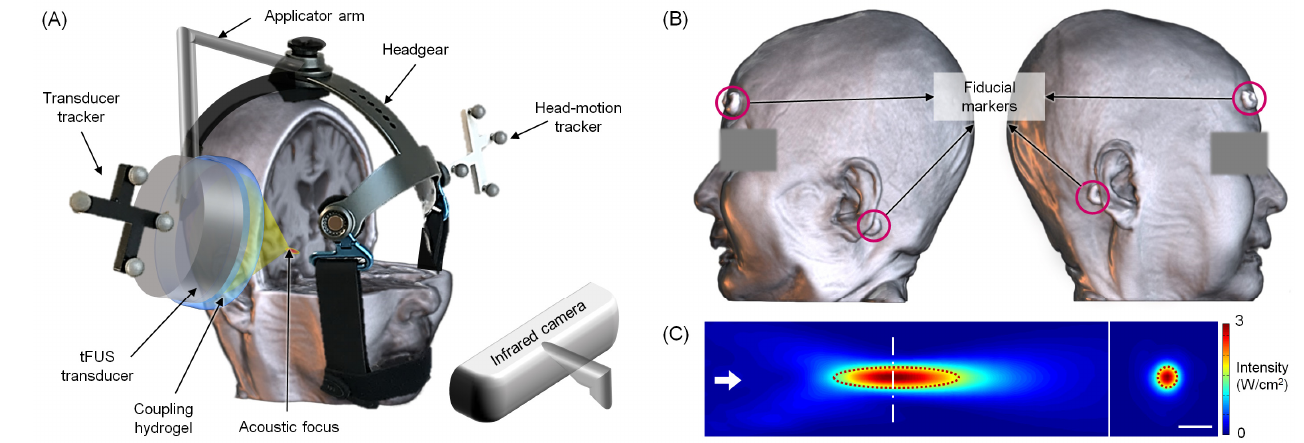
Figure 2. ( A ) Illustration of the experimental setup for transcranial focused ultrasound (tFUS) sonication to the right hippocampus of patients with Alzheimer’s disease. Image-guided real-time navigation was performed using the motion-tracking infrared camera which monitors the location and orientation of the headgear and the FUS transducer through optical trackers. The transducer is placed over the entry point on the scalp, and the coupling hydrogel is positioned between the transducer and the scalp. The sonication path is overlaid on the T1-weighted magnetic resonance imaging (MRI) of a patient. ( B ) A 3D visualization of four fiducial markers that were placed on the patient’s head during the acquisition of MRI and computed tomography (CT) scans. The markers were used as reference coordinates to co-register the patient’s virtual (MRI and CT) and real space for image-guided tFUS sonication. ( C ) The acoustic intensity profile of the FUS transducer along the sonication direction (the left panel; the sonication direction is depicted in an arrow) and from the transversal section at the focus at a centerline (shown in the right panel). The dotted red lines indicate the profile bound by the full-width at half-maximum of the peak intensity. Bar = 10 mm. The measurement was conducted in degassed water. The detailed methods were described in Jeong et al. 2021 [16].